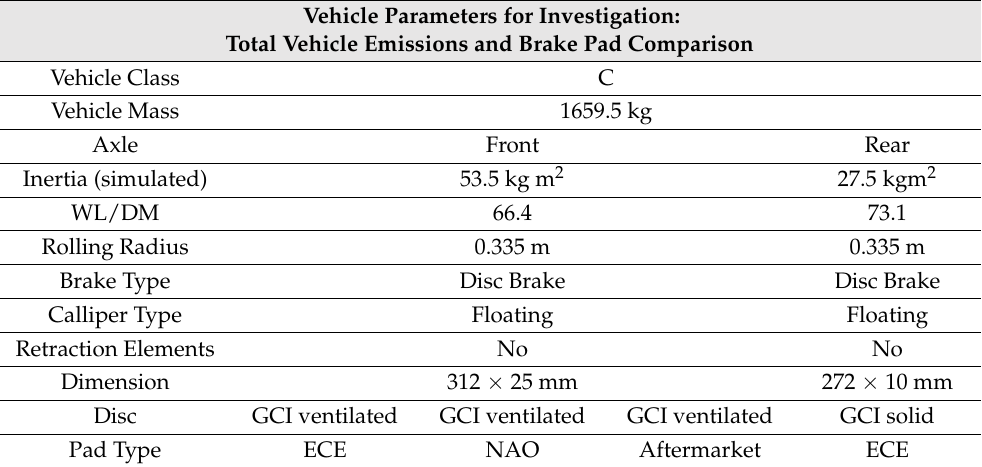
Table 1. Vehicle parameters for investigation: total vehicle emissions and brake pad comparison. Vehicle Parameters for